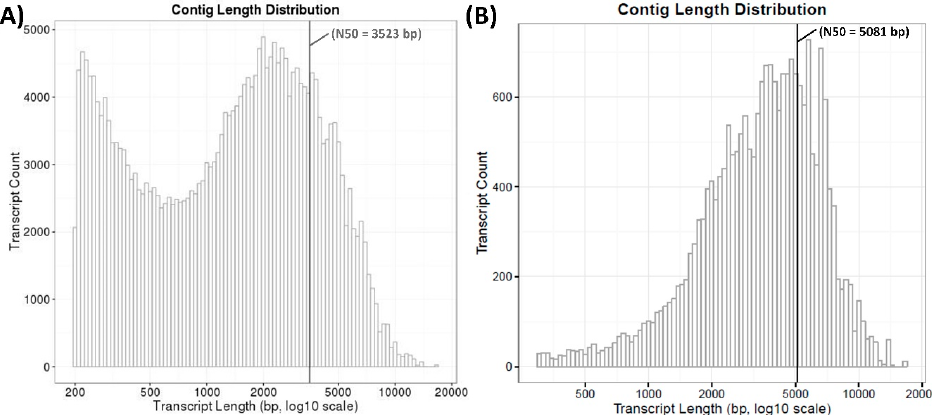
Figure 1. Sequence length distribution of transcripts of A. sinapina after Trinity de novo assembly ( A ; N50 = 3523bp) and after BLAST annotation and filtered annotated components ( B ; N50 = 5081bp).